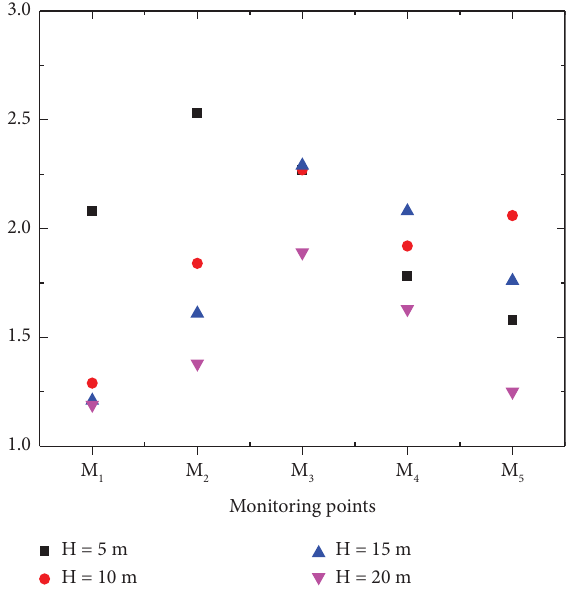
Figure 6: PPV on measuring points of blasting with a vibration- isolating slot with diferent depths.